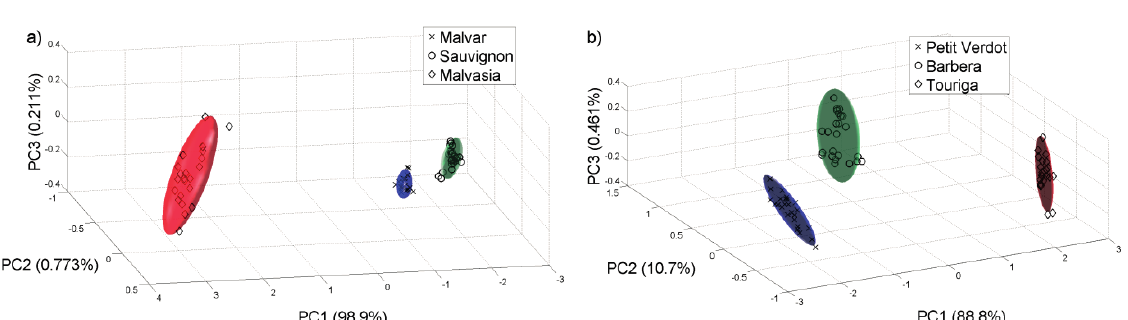
Figure 8. PCA plot for different grades of grape ripening in 2012. ( a ) Chenin Blanc; ( b ) Barbera.